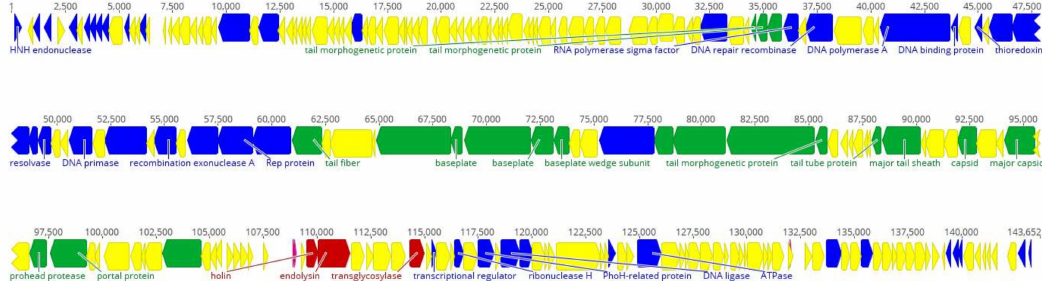
Figure 2. Genome overview of the Staphylococcus phage LM12. Genome map with predicted 227 coding sequences (CDSs) numbered and colored (yellow shows hypothetical proteins, blue shows DNA replication and transcription genes, green represents DNA packaging and phage morphogenesis genes, and red indicates cells lysis genes) according to their predicted function. Some important CDSs are highlighted. Above the genome, the nucleotide position in kb is given. The figure was performed using Geneious